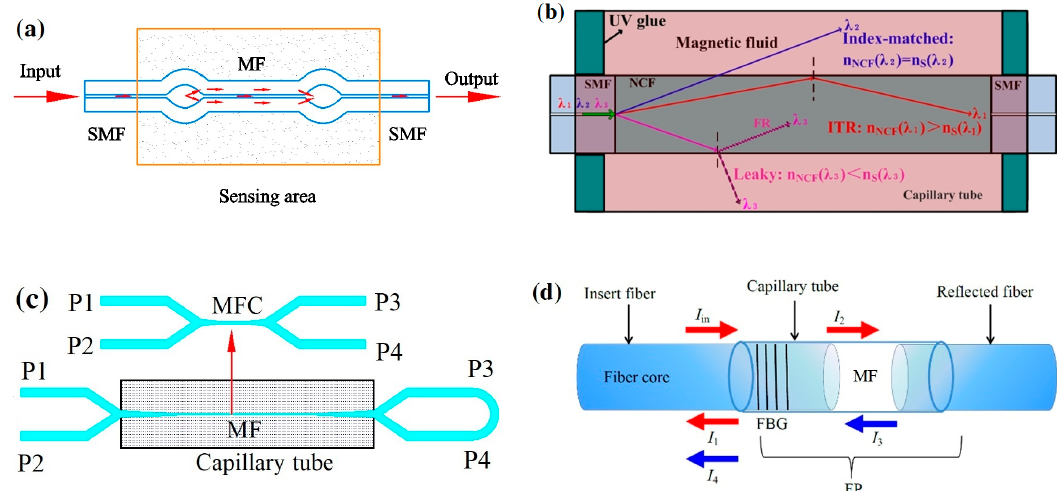
Figure 9. ( a ) Sensing arm of sensor based on fiber spherical-structure interferometer and MF [63], ( b ) sensor probe structure of single mode fiber (SMF)- no-core fiber (NCF)-SMF encapsulated in capillary tube filled with MF [67], ( c ) sensor probe based on the Sagnac loop with microfiber coupling structure [69], ( d ) sensing head based on F-P interferometer and MF [70].